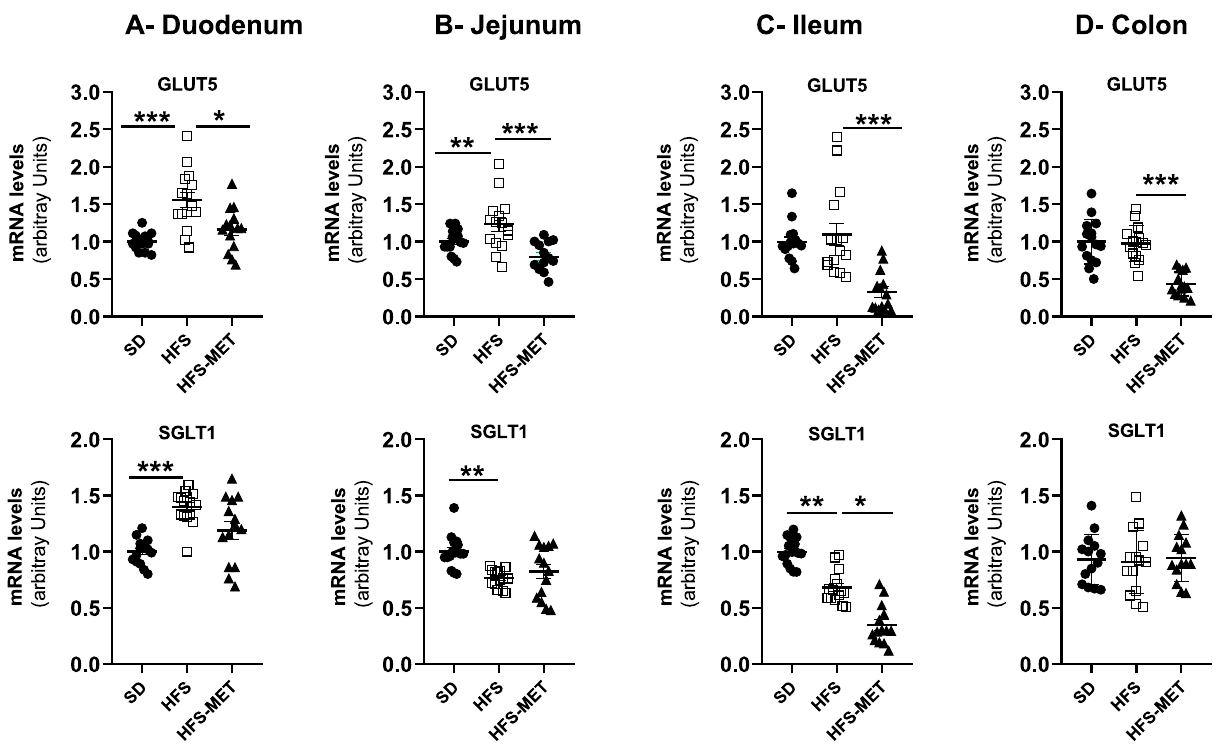
Figure 2. Effects of HFS diet and metformin treatment on apical glucose transporter gene expression in the different regions of the intestine. GLUT5 and SGLT1 mRNA levels were determined by RT-qPCR in ( A ) the duodenum, ( B ) jejunum, ( C ) ileum and ( D ) colon of 15 to 18 mice per group ( SD standard diet, HFS high fat high sucrose diet, HFS-MET HFS diet with metformin supplementation). *p < 0.05, **p < 0.01, ***p < 0.001, determined by ANOVA followed by Tukey’s multiple comparison